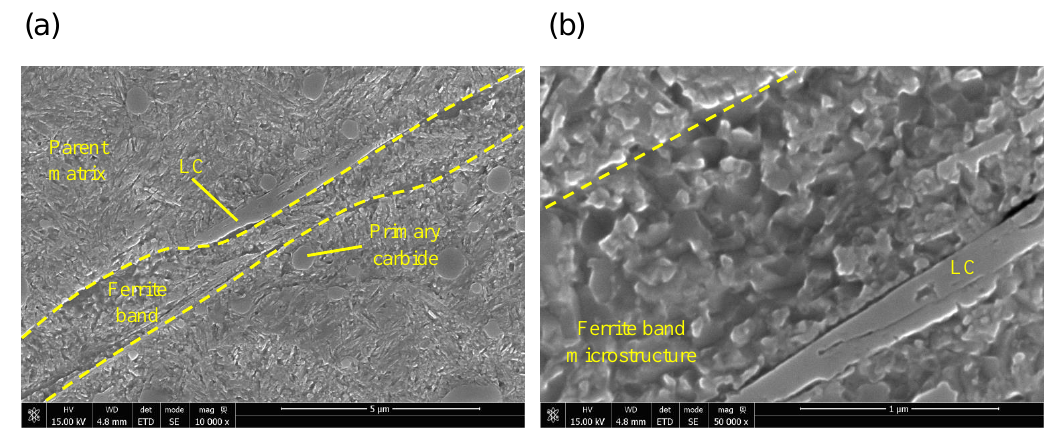
Figure 5. SEM images of WEBs. ( a ) Typical WEB structure. ( b ) Ferrite band microstructure.